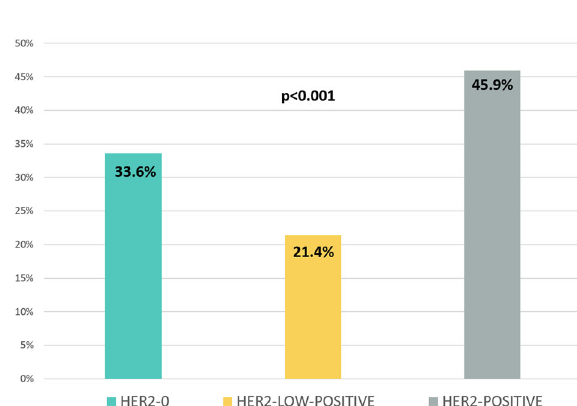
Fig. 2 pCR rates according to HER2 expression. This bar chart shows pCR rates across subgroups de fi ned by HER2 expression ( p -value obtained with χ 2 test).